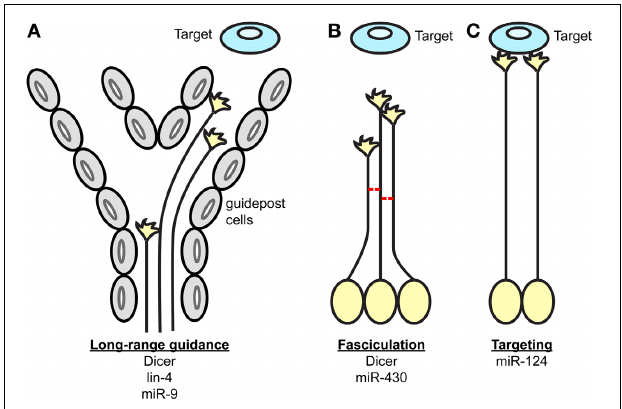
FIGURE 1 | Key processes of axon guidance regulated by miRNAs. During axon pathfinding toward a target, miRNAs regulate (A) the long-range guidance of axons by acting within projection neurons and/or guidepost cells located along permissive corridors or at the midline, (B) the fasciculation of axons in a given tract, and (C) the restriction of the axonal targeting area. The components of the miRNA pathway involved in each process are specified under each